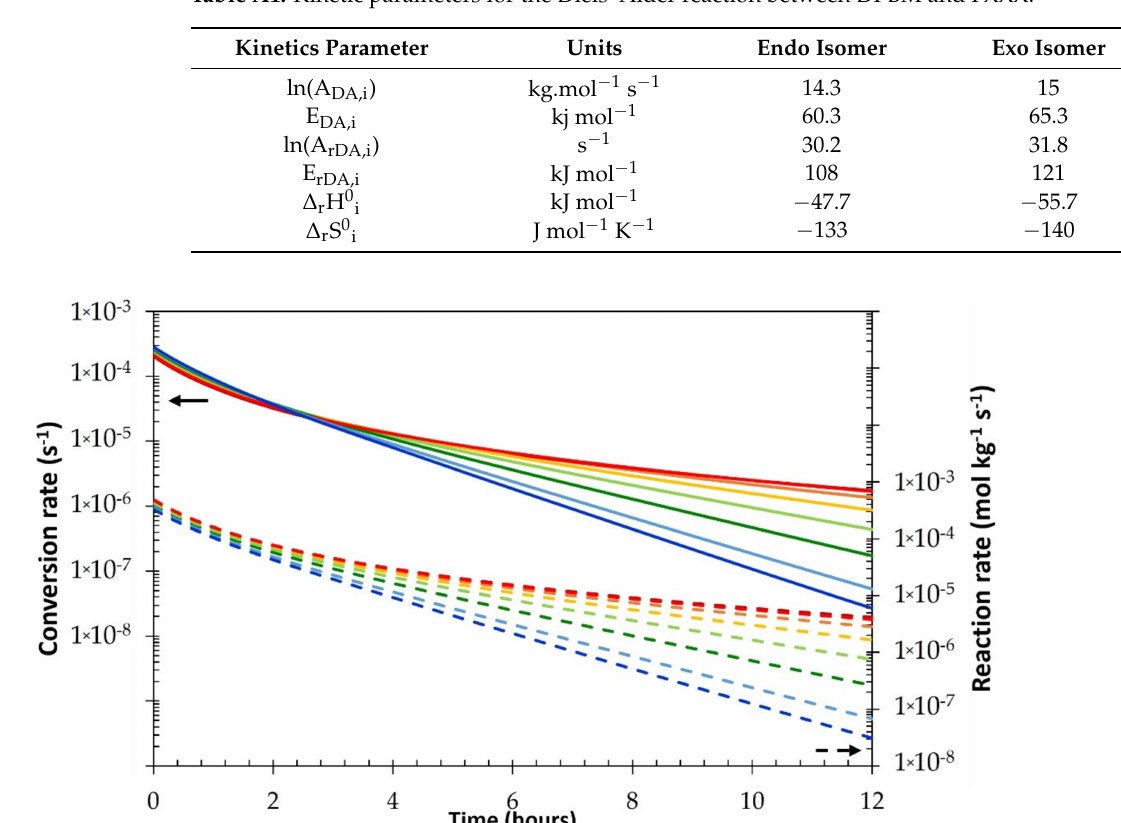
Table A1. Kinetic parameters for the Diels–Alder reaction between DPBM and FXXX.